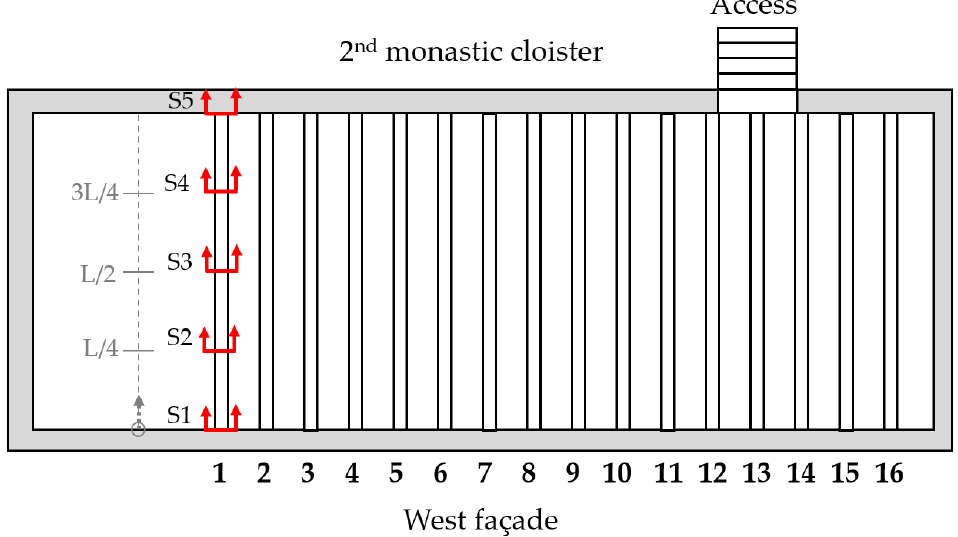
Figure 3. Scheme of the 16 wooden beams of the floor under analysis. L: Total length of each wooden beam. S1, S2, S3, S4 and S5: Measurements points of the beam section.